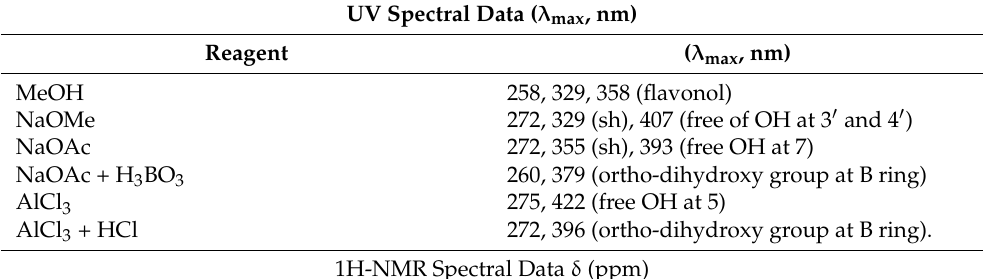
Table 2. UV and 1 H-NMR spectral data of rutin compound.